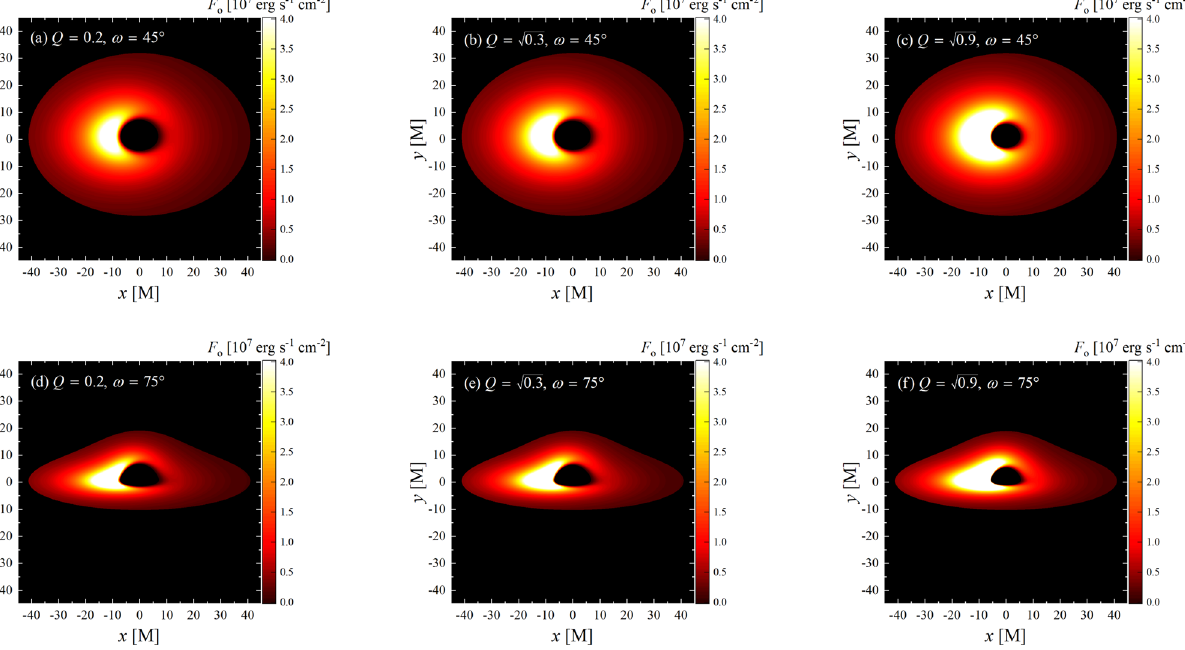
Fig. 10 Similar to Fig.9, but for RN